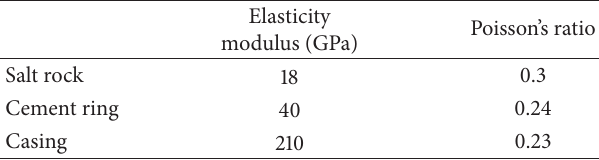
Table 2: Material mechanical parameters.